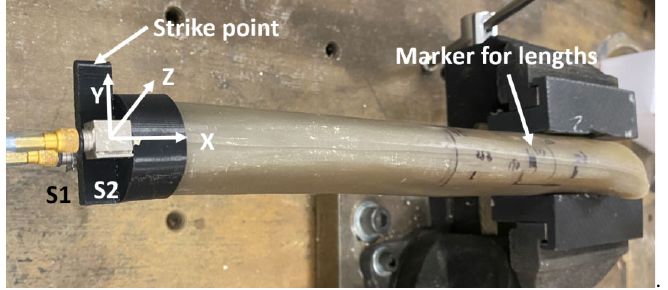
Figure 3. Two-sensor (S1 and S2) setup for composite femur model with markers for three residual length conditions.